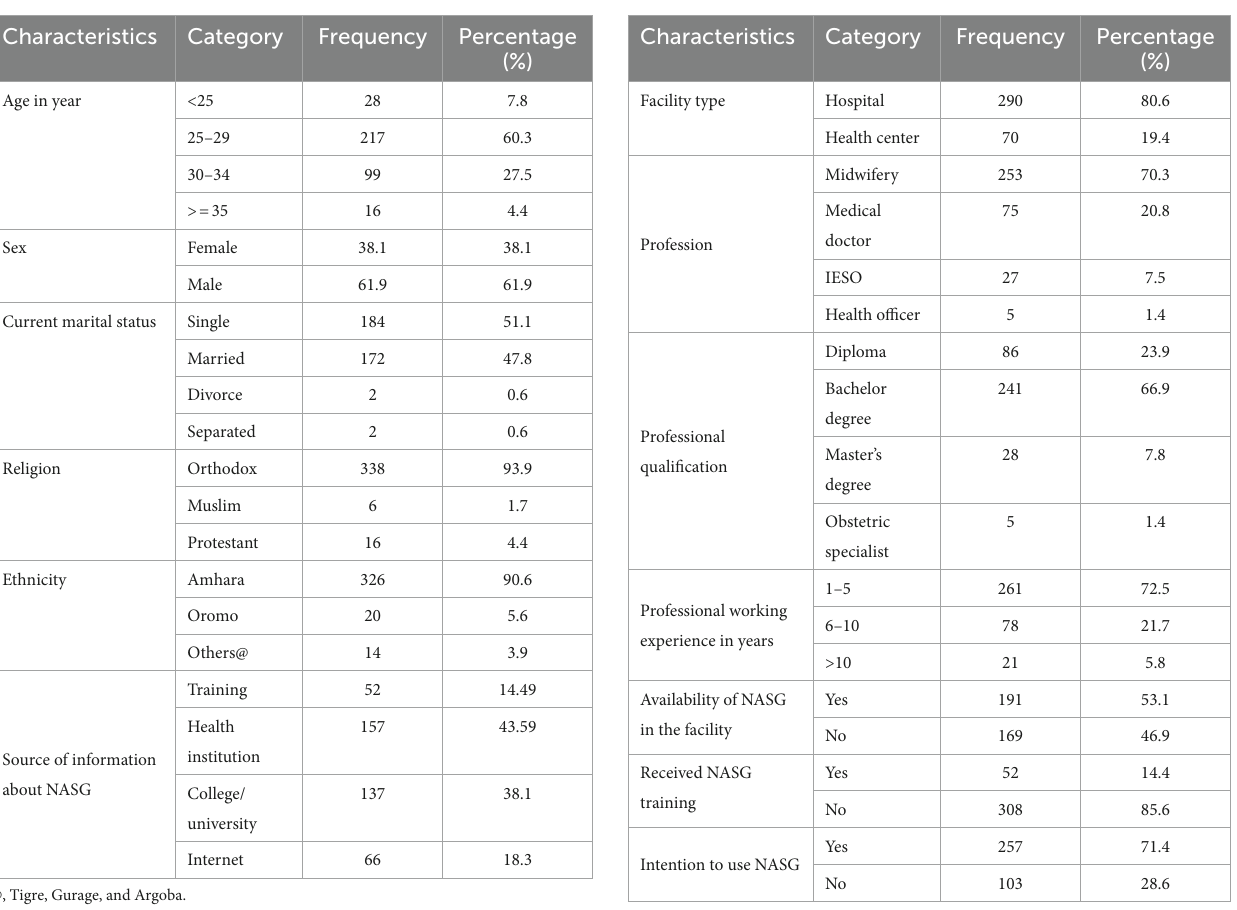
TABLE 1 Socio-demographic characteristics of study participants among healthcare providers in north Shew Shewa zone health facilities, 2021 ( n = 360).